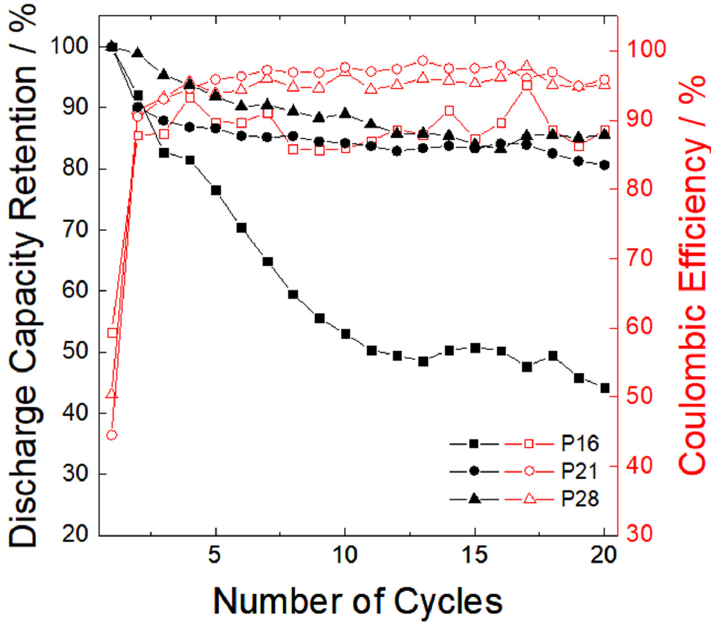
Figure 4. Variations in discharge capacity retention and coulombic efficiency with charge–discharge cycle at a rate of 0.2 C.